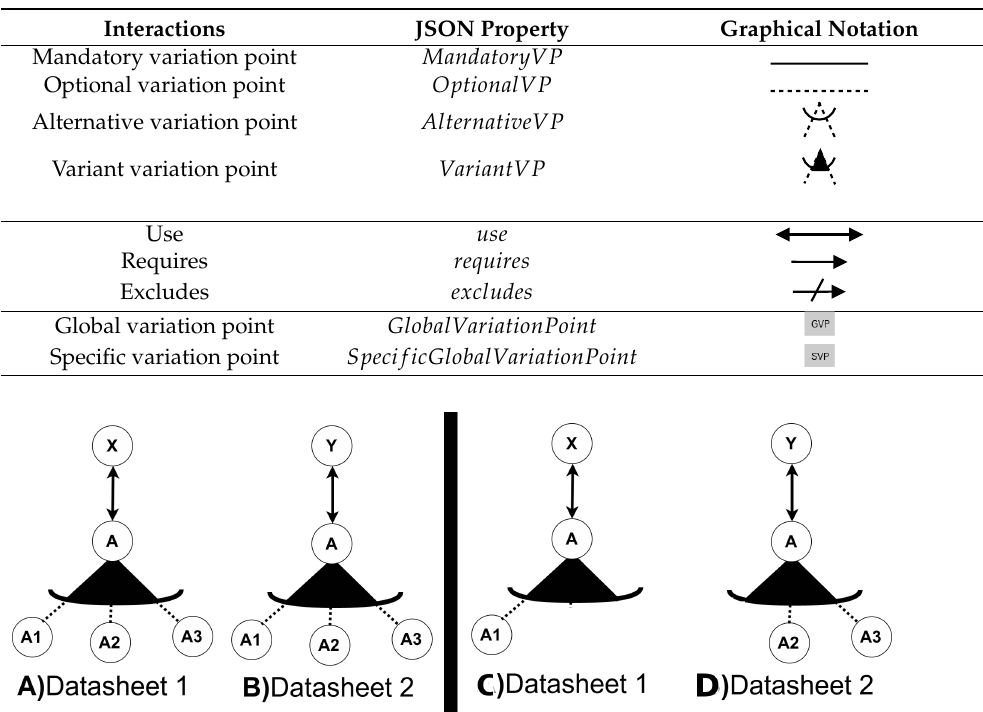
Table 1. Interactions defined for modeling SeVaTax models.